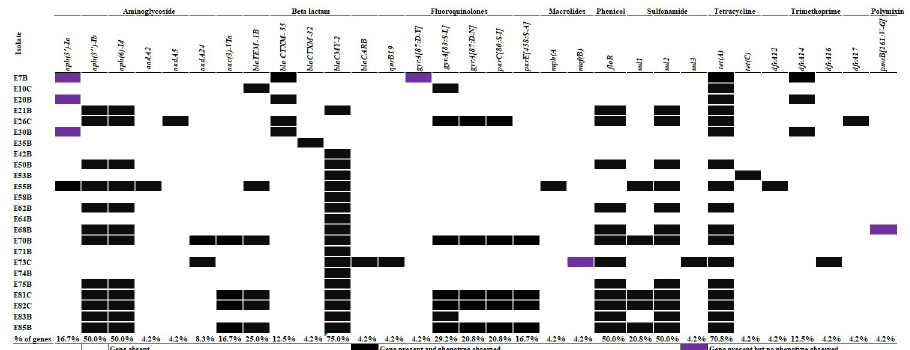
Fig 1. Genetic determinants of antibiotic resistance among E . coli isolated from cattle feces on a dairy farm in Texas. Black cells indicate the presence of a genetic resistance determinant and a phenotype of that determinant in a bacterial isolate. Purple cells indicate the presence of a genetic resistance determinant without a corresponding phenotype in the same isolate. White cells indicate the absence of both genetic resistance determinant and corresponding